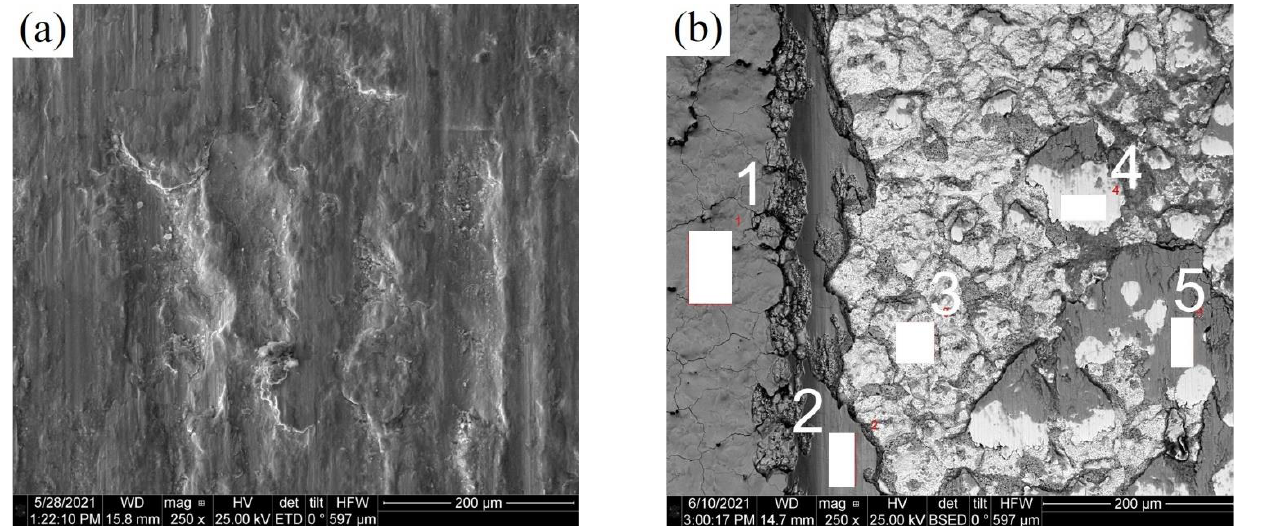
Figure 9. SEM image of wear tracks of the steel surface before ( a ) and after cathodic PENC for 30 min ( b ).